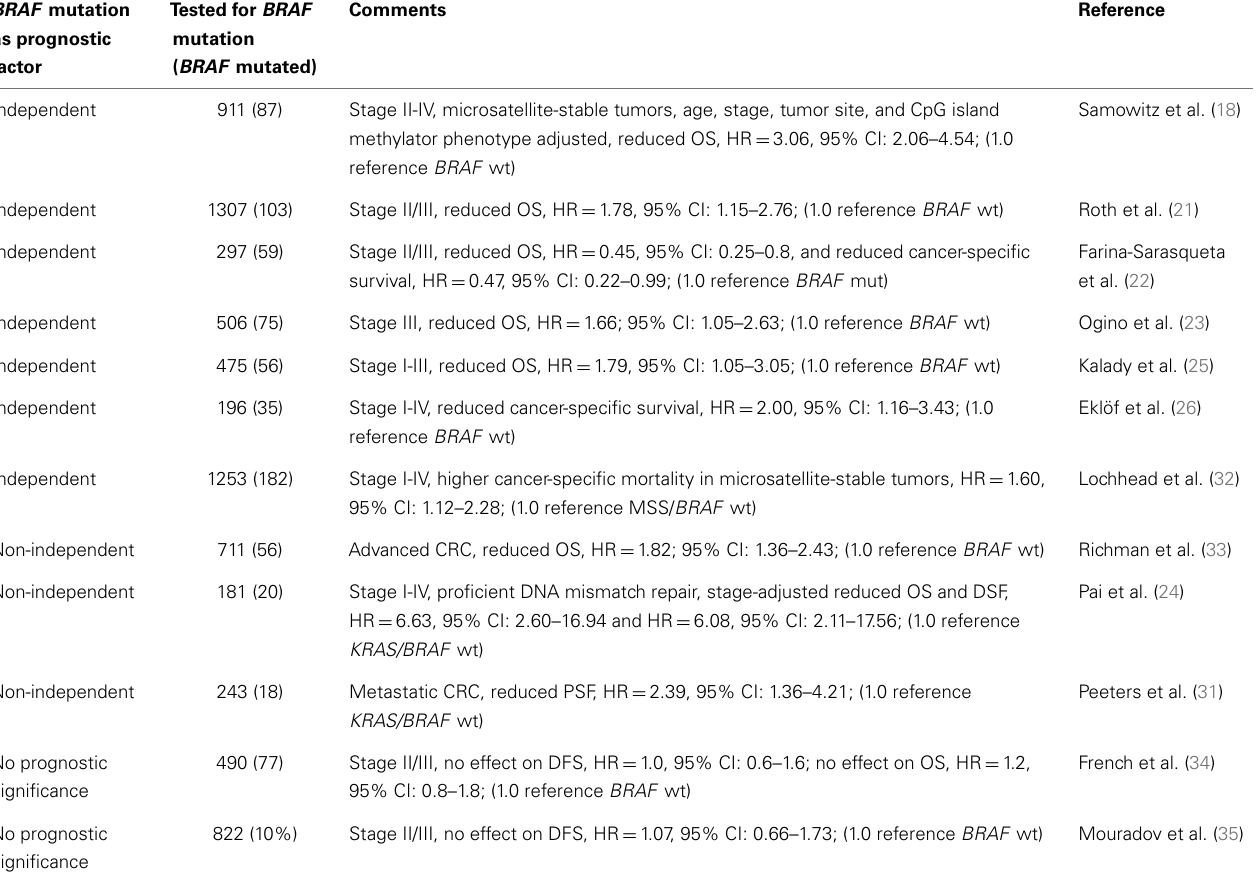
Table 1 | BRAF mutation as prognostic factor in colorectal